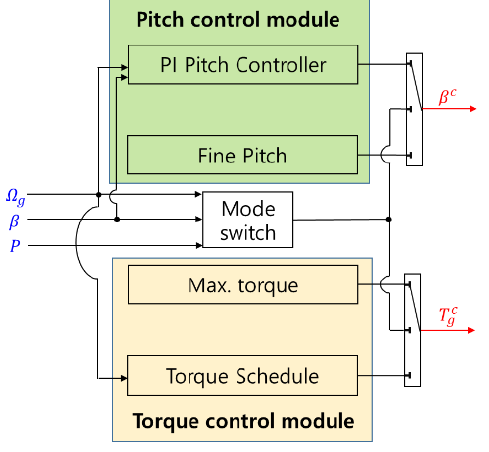
Figure 3. Block diagram of the PI control algorithm. In the maximum power coefficient region, the control strategy aims to maintain the optimal power coefficient (C p ) in order to maximize the power output. For this, the blade pitch angle is fixed to the fine pitch angle, and the generator torque is adjusted based on the measured generator speed to achieve the optimal speed ratio. In this study, a look-up table using the generator speed as the input and the generator torque as the output was constructed based on a steady-state analysis to achieve the optimal tip speed, and it was used for the generator torque command. The look-up table is shown in Figure 4. The two linear lines at both ends of the nonlinear curve represent the two transition regions for starting and the smooth connection to the rated power region.